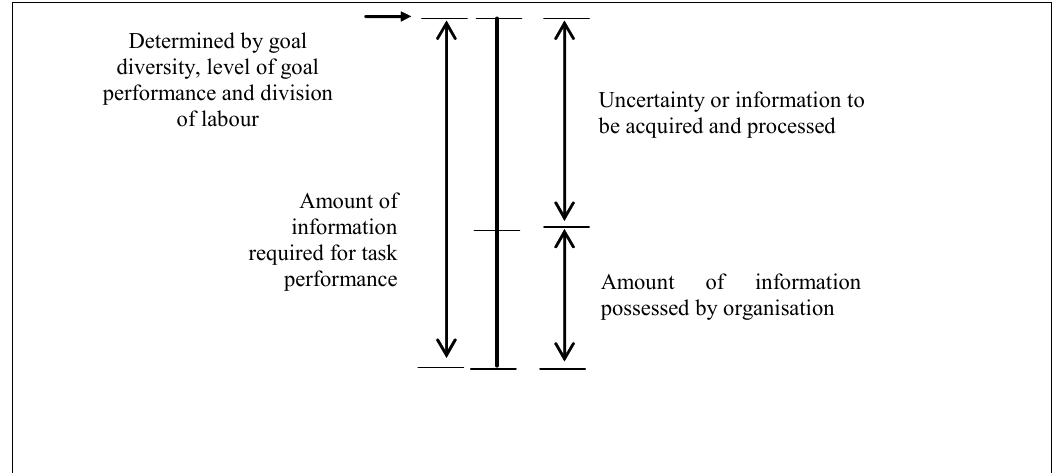
Figure 2: The tower of alignment for the effective use of IS in organisations (Garg 2003)